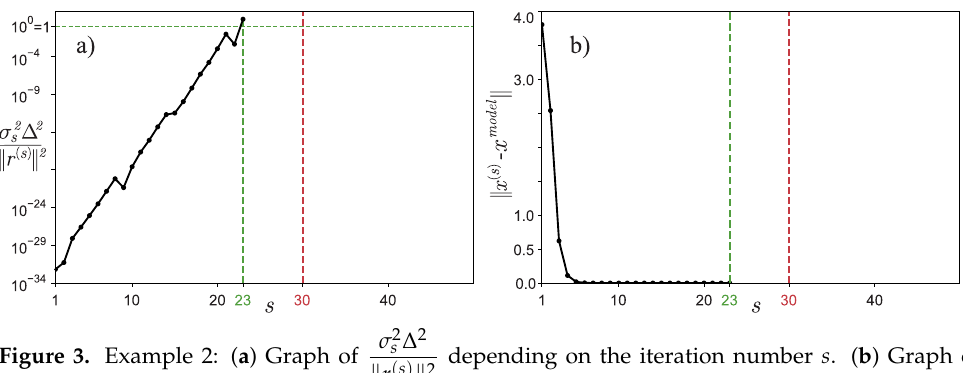
Figure 3. Example 2: ( a ) Graph of